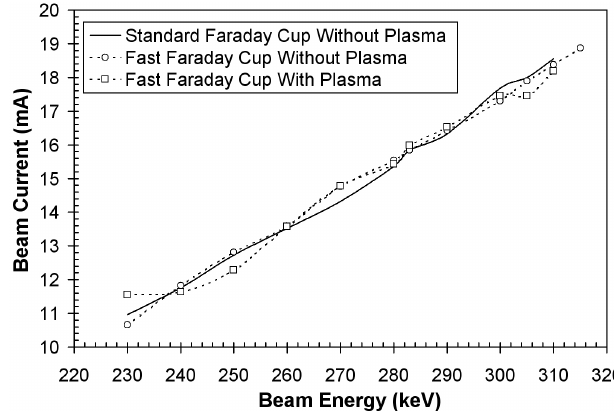
FIG. 5. Uncompressed ion beam current, I beam energy: (solid line) standard Faraday cup without plasma; (dotted line, circles) fast Faraday cup without plasma; (dotted line, squares) fast Faraday cup with plasma.